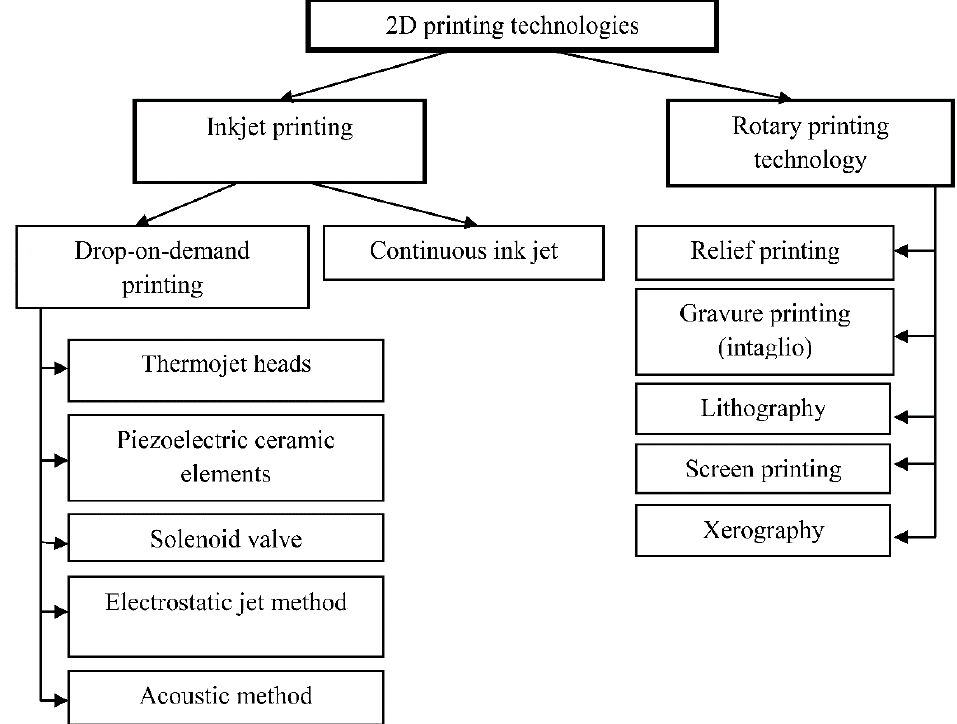
Figure 2. The technologies employed in 2D printing. Inkjet printing is a general term that covers a wide range of approaches to the formation and placement of small liquid droplets using digital control. Inkjet technology is generally classified as continuous inkjet (CIJ) and on-demand printing (drop-on-demand, DOD)